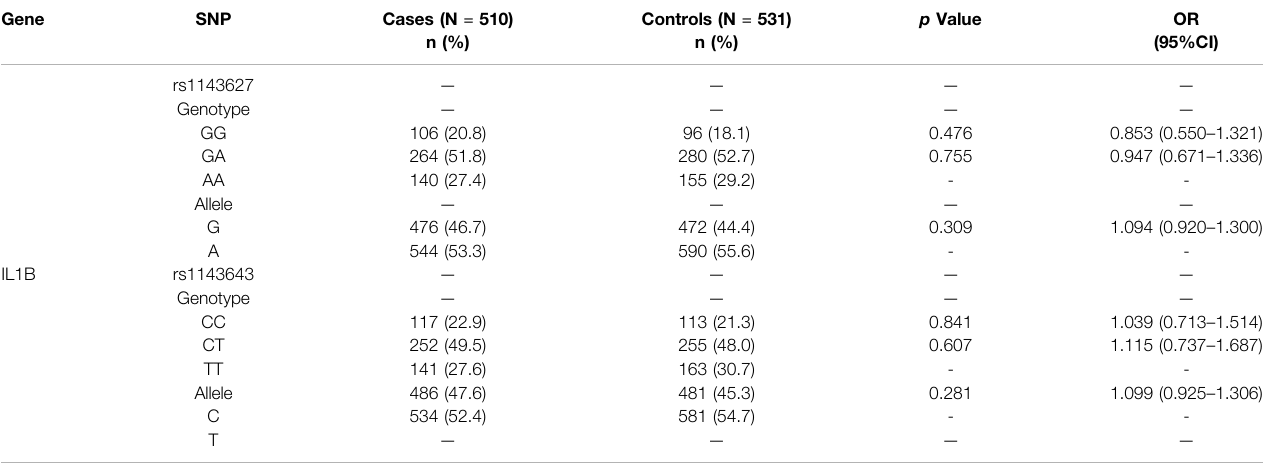
TABLE 3 | Genotype and allele frequencies of rs1143627 and rs1143643 between T1DM patients and controls (numbers of genotypes and alleles (%) or (95% CI)]. Gene SNP Cases (N = 510)